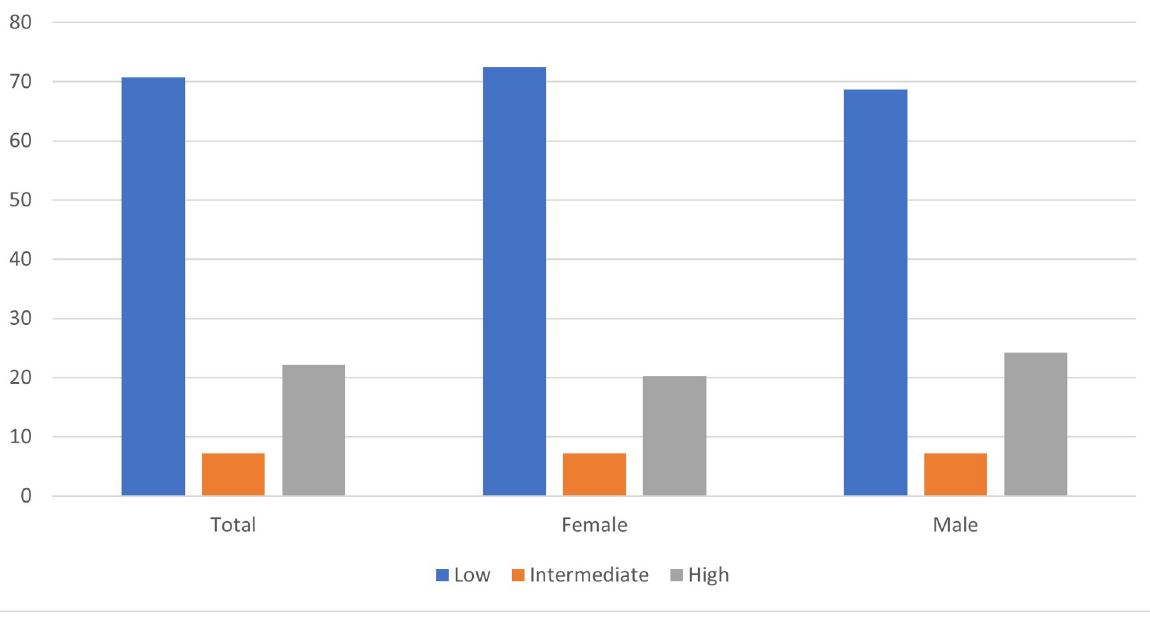
Fig 1. Atherogenic index among